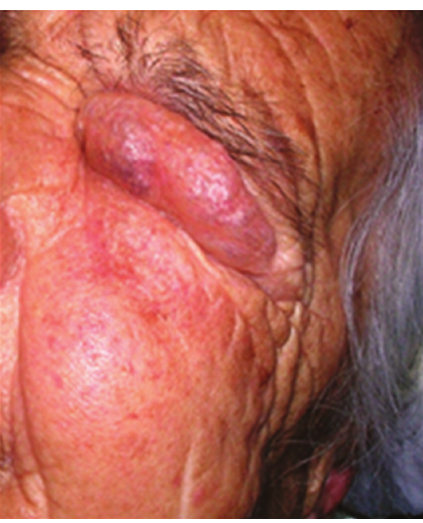
Figure 1: Extensive subcutaneous emphysema involving left hemi- face and left orbit.